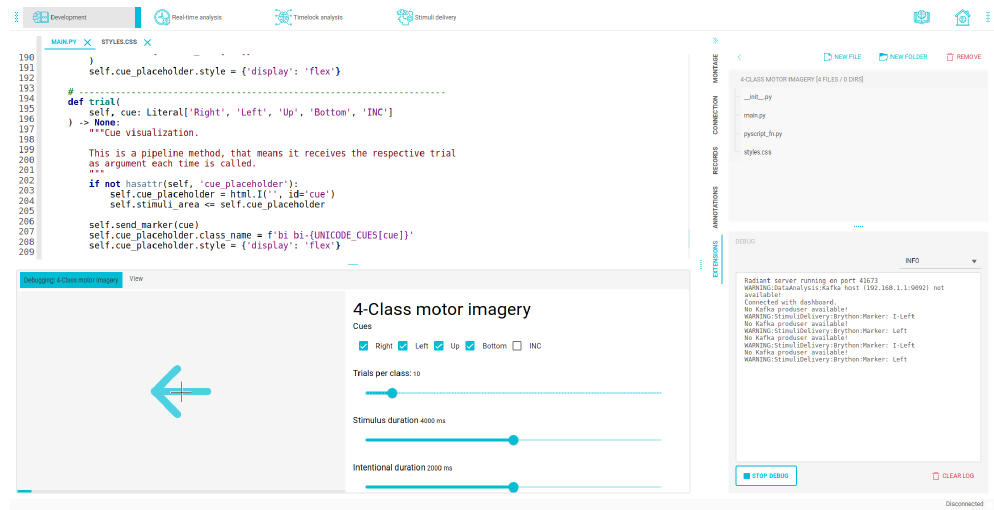
Figure 19. Integrated development interfaces displaying areas for code editing, file explorer, experi- ment preview, and debugging area for our OpenBCI